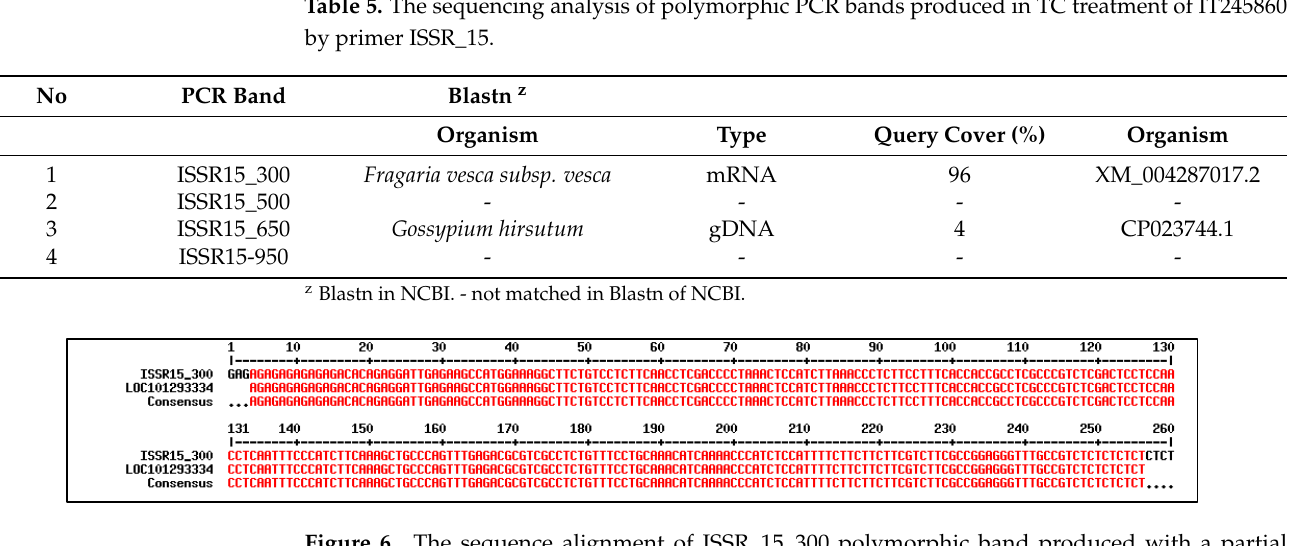
Figure 6. The sequence alignment of ISSR_15_300 polymorphic band produced with a partial uncharacterized gene of Fragaria vesca subsp. vesca , LOC101293334, by using Multalin software (http://http://multalin.toulouse.inra.fr/multalin/ assessed on 25 May 2022) for comparison. Table 5. The sequencing analysis of polymorphic PCR bands produced in TC treatment of IT245860 by primer ISSR_15.